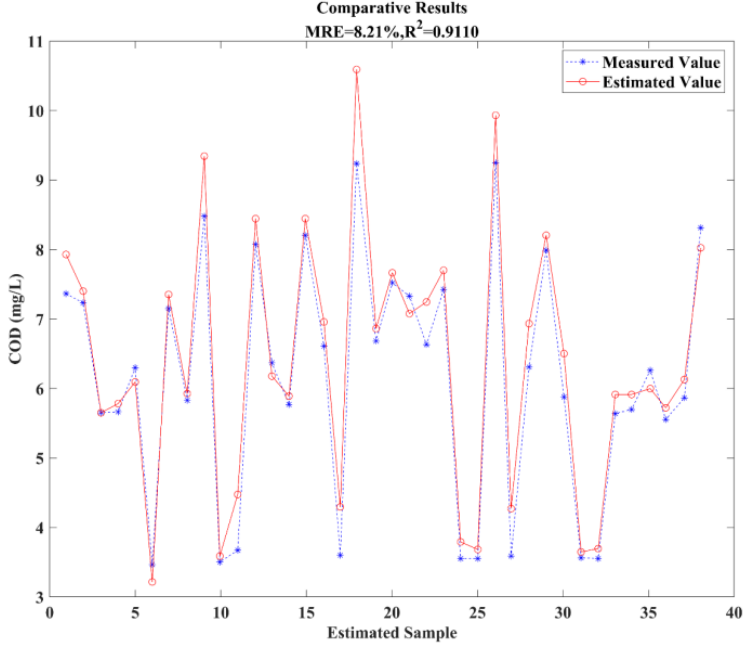
Figure 8. Comparative results of the DWQM model. It can be seen from the simulation results that both the SWQM model and the DWQM model can estimate the changing trend of chemical oxygen demand. Compared with the SWQM model, the DWQM model shows smaller average relative error (MRE) and a larger absolute coefficient, indicating that the improved model is more suitable for the numerical estimation of